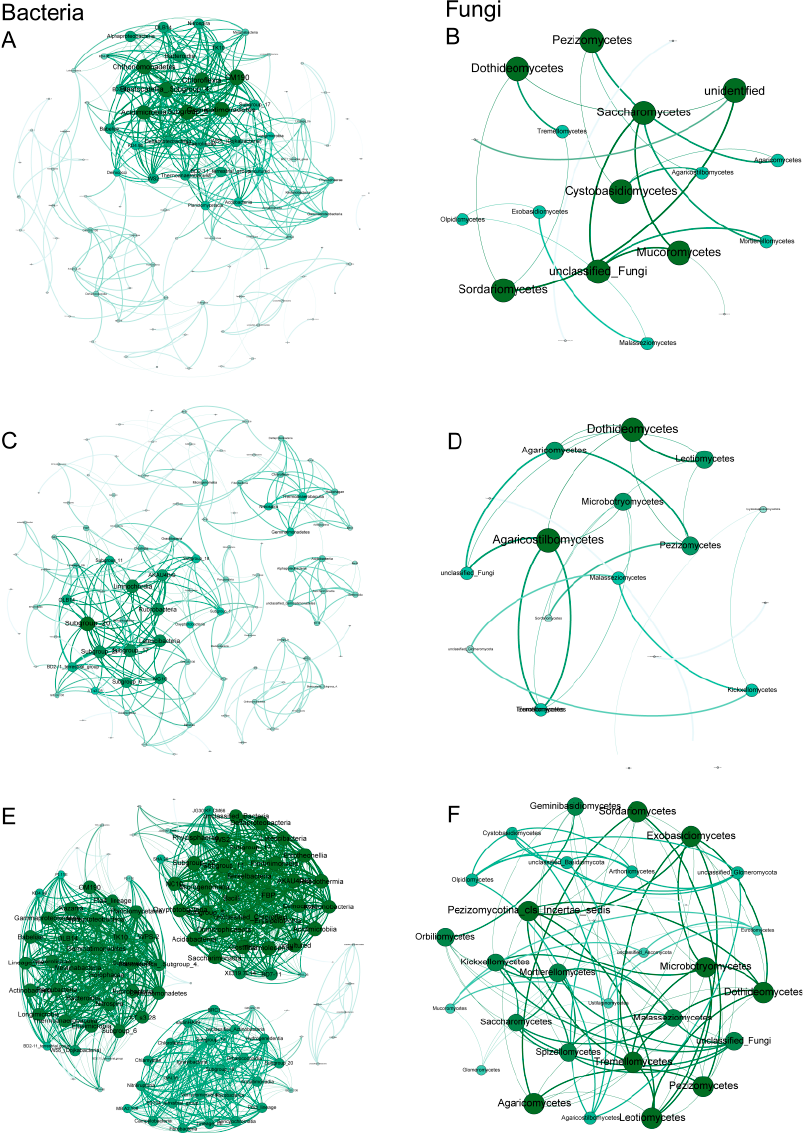
Figure 6. Network diagrams at the level of bacteria and fungi, where ( A , B ) are the network diagrams of soil bacteria and fungi at the level of DM long-term continuous crop of food crops, respectively; ( C , D ) are the network diagrams of soil bacteria and fungi at the level of DG long-term continuous crop of medicinal plants, respectively; ( E , F ) are the network diagrams of soil bacteria and fungi at the level of CK long-term fallow.